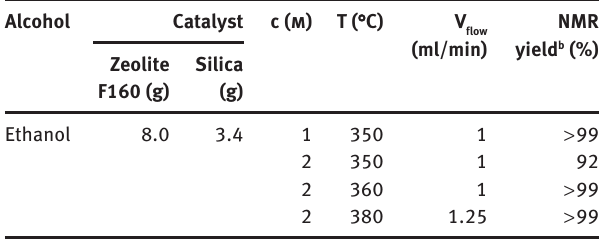
a Reaction conditions: 13 ml void volume, 90 bar pressure. Yields and selectivities were > 99%, based on 45 MHz picoSpin nuclear mag- netic resonance (NMR) and gas chromatography-mass spectrometry (GC-MS). b Based on 45 MHz picoSpin NMR data.